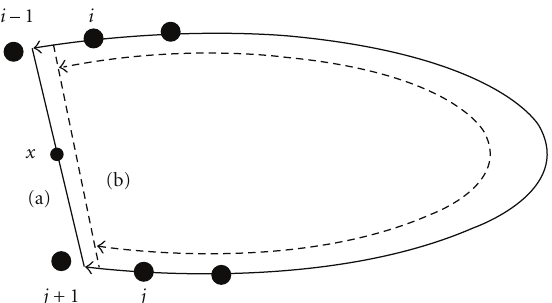
Figure 7: Discrete view sampling: true pi-line, (a) in solid line and approximated pi-line, (b) in dashed line, due to the discrete view sampling. Note that pi-segment associated with (b) is now smaller.